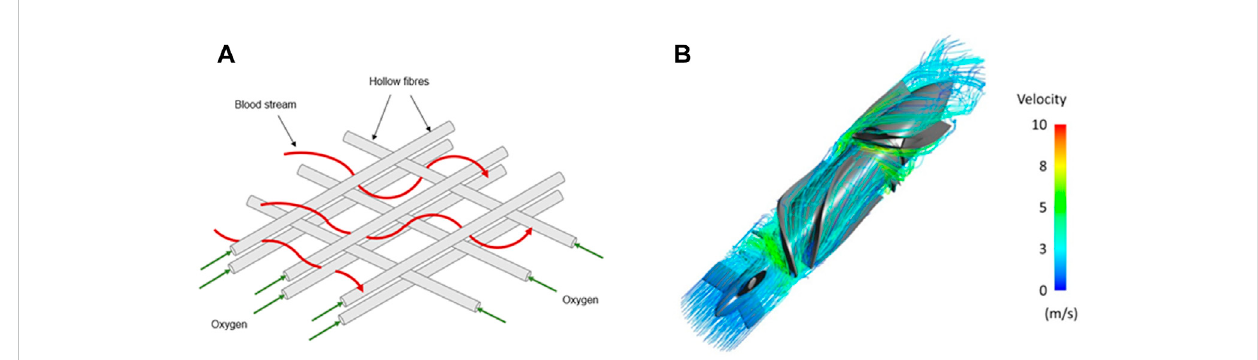
FIGURE 2 Blood streamlines in classical blood-circulating devices. Blood stream navigating through a compact net of hollow fi bres transporting oxygen in classical EMCOs (A) or blood pump (B) . In both cases, blood undergoes major fl ow disturbances that include expansions and constrictions. Panel B is modi fi ed from Romanova et al.,